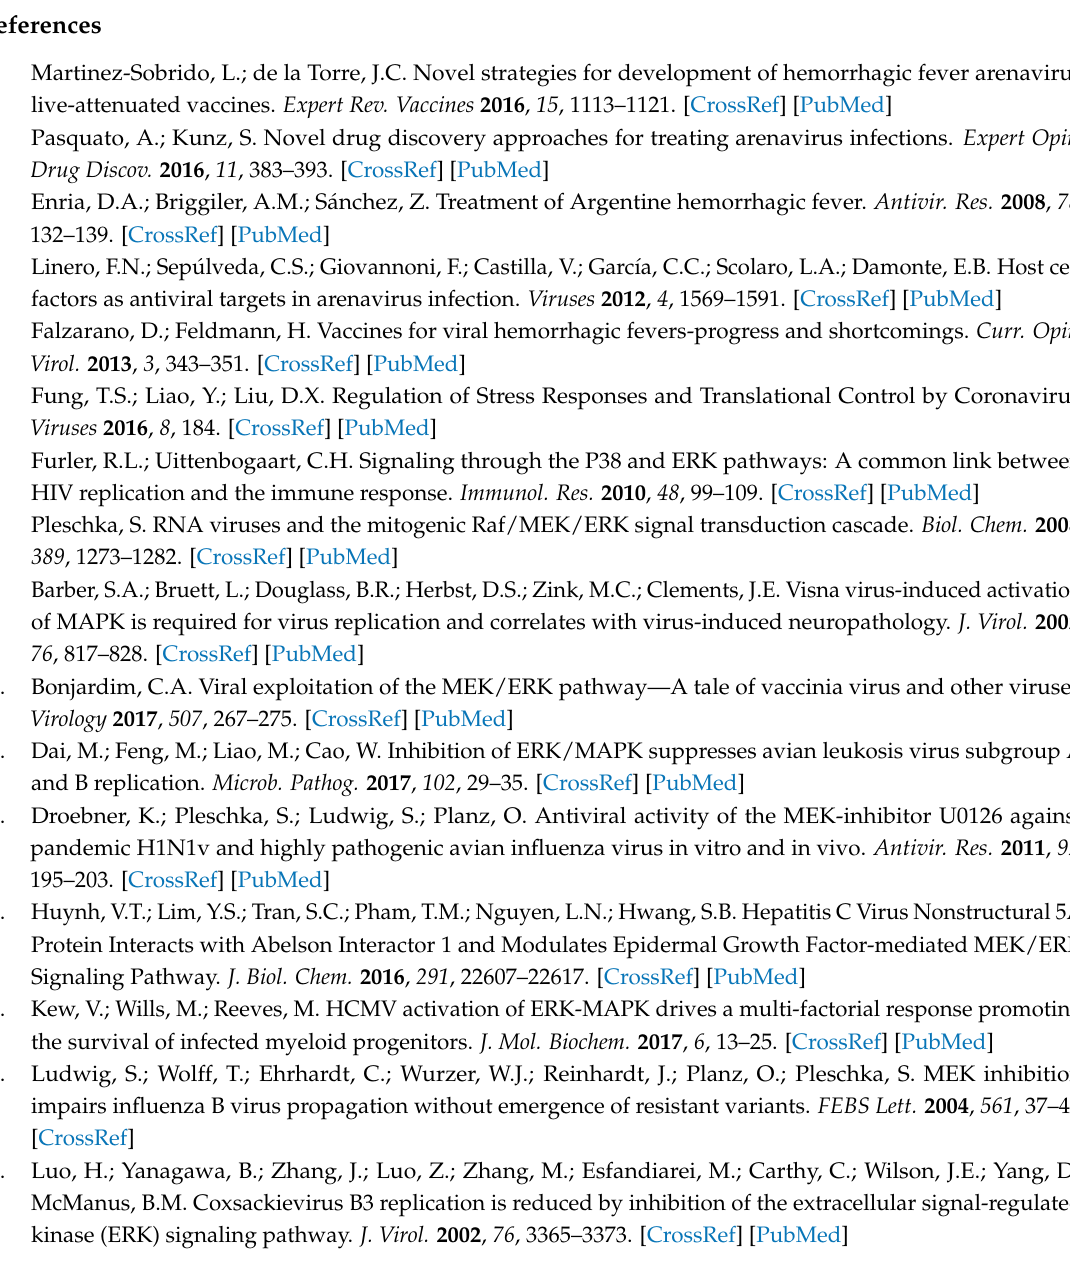
Figure S1: Effect of U0126 treatment on the viability of JUNV infected Vero cells; Figure S2: Effect of U0126 treatment on the viability of BSR